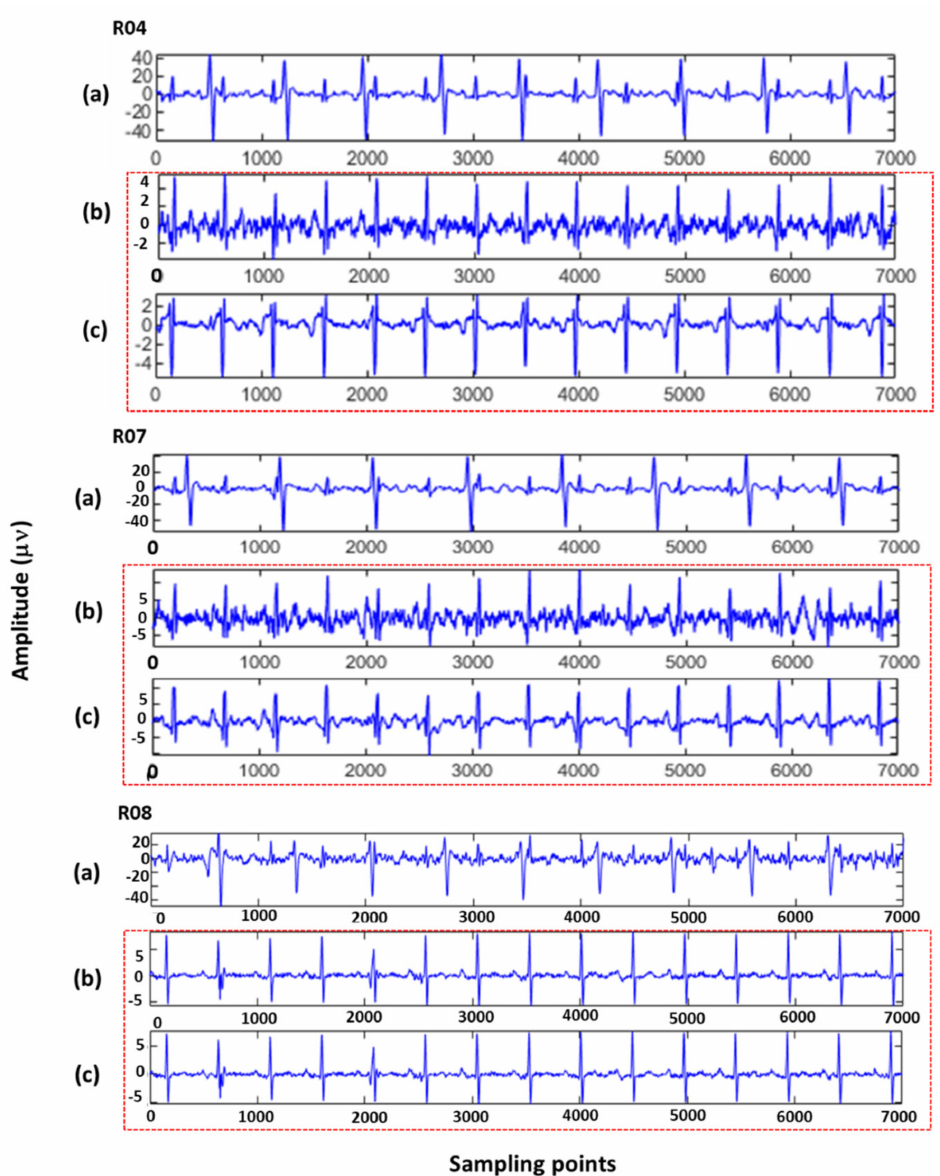
Figure 4. A total of 7000 sampling points of R04, R07, and R08 data in the ADFECGDB database were applied to the extraction algorithm: ( a ) Maternal abdominal mixed signals (R04, R07, and R08 signals were, respectively, used as the maternal abdominal mixed signals of the third, third and second channels); ( b ) FECG signals estimated by the SVD algorithm; and ( c ) FECG signals extracted by the proposed